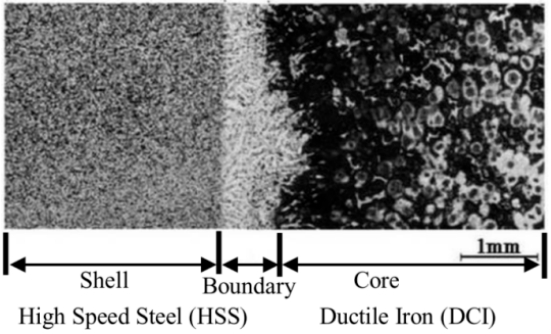
Figure 2. View of microstructure for a high-speed-steel-type roll with a ductile core. *Reproduced with permission from Noda et al., Journal of the Japan Society for Technology of Plasticity, 2018.